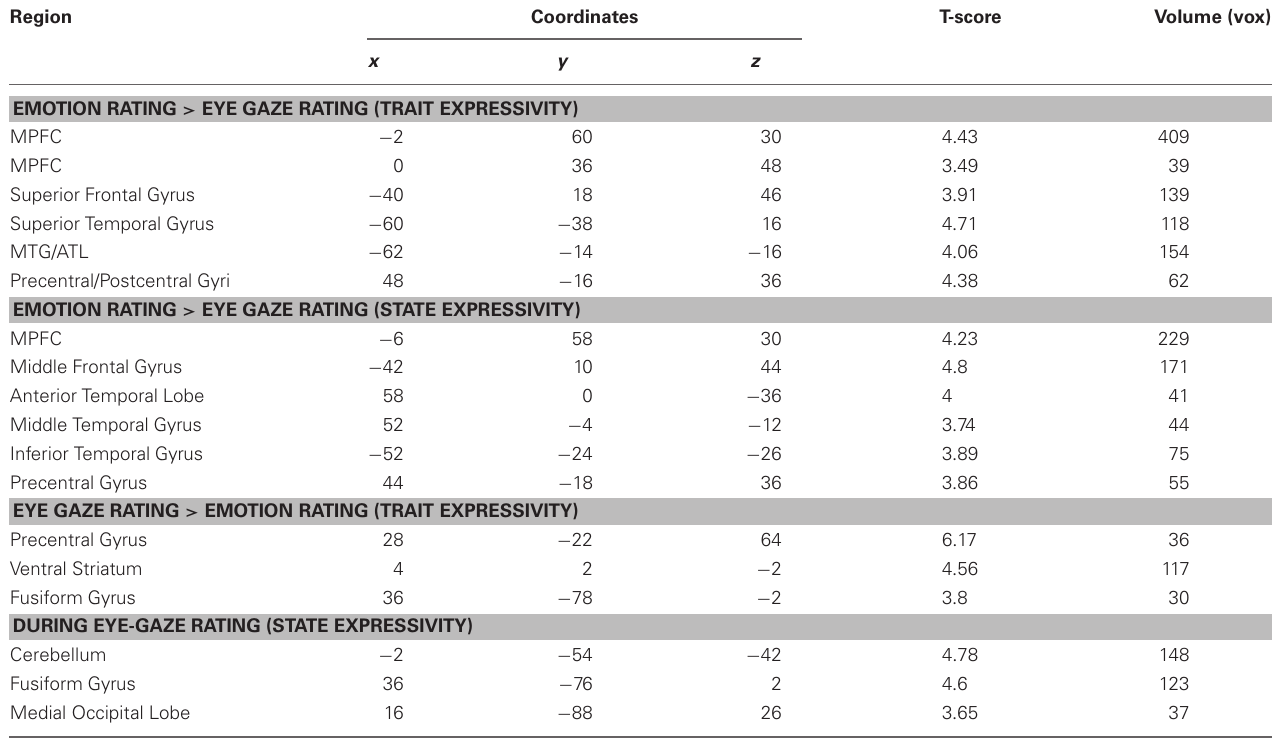
Table 3 | Direct comparisons of expressivity related effects across conditions. Region